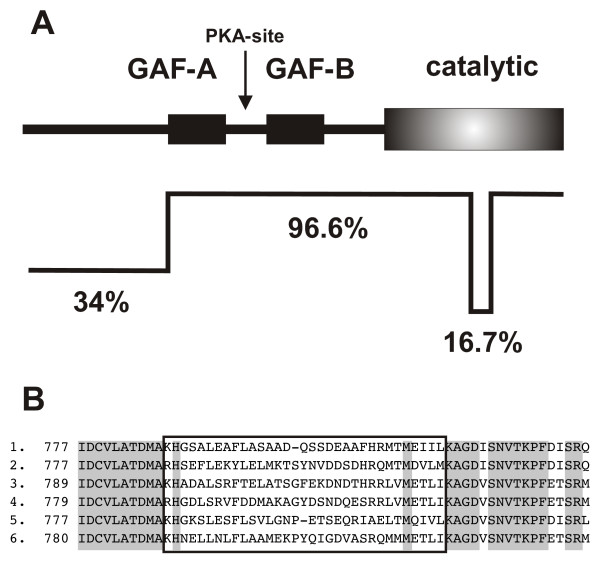
Sequence organization and comparison of LmjPDEB1 and LmjPDEB2. Panel A: Extent of amino acid sequence identity between various parts of LmjPBEB1 and LmjPDEB2. A 24 amino acid stretch within the otherwise identical catalytic region is entirely dissimilar between the two. Panel B: similar stretches of sequence divergence (boxed area) are found at identical positions within the otherwise highly conserved catalytic regions the T. brucei and T. cruzi homologues. 1: TbrPDEB1; 2: TbrPDEB2; 3: LmjPDEB1; 4: LmjPDEB2; 5: TcrPDEB1; 6: TcrPBEB2.